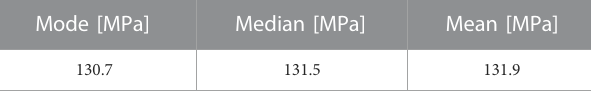
TABLE 9 Mode, median, and mean value of the lognormal distribution of the equivalent shear strength C of the HDCR hydrates, see also Eqs 39, 40. Mode